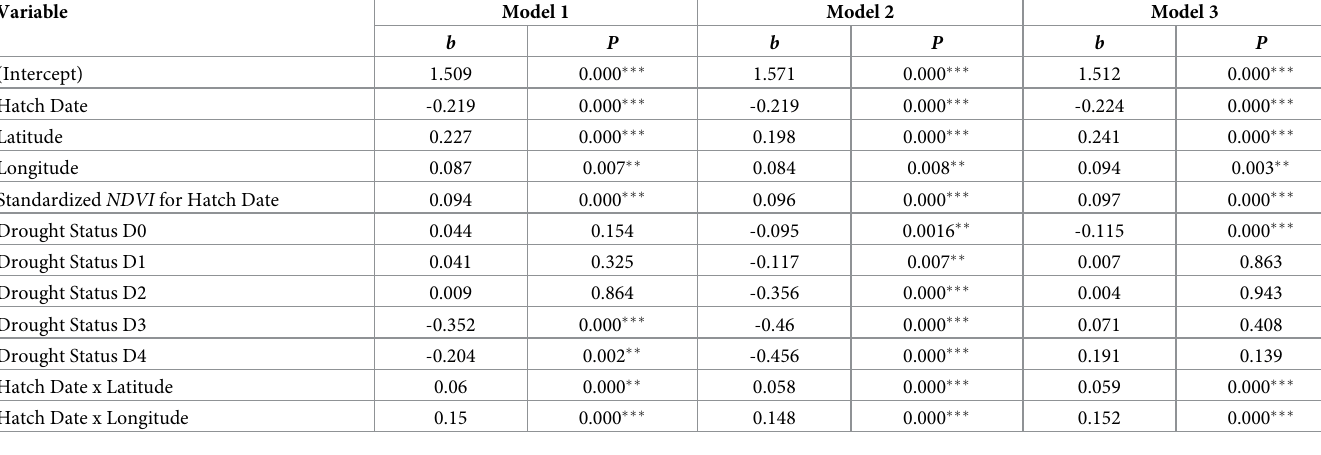
Table 3. Parameter β estimates ( b ) and probabilities ( P ) for three generalized linear models used to evaluate drought effects on Eastern Bluebird hatching success rate. Explanatory variables for all models include Julian lay date, latitude, longitude, standardized NDVI for the Julian hatch date, drought status during the Julian hatch date, and interactions between Julian hatch date and latitude and Julian hatch date and longitude. Models 2 and 3 evaluate drought status 30 days and 60 days prior to the Julian hatch date, respectively.